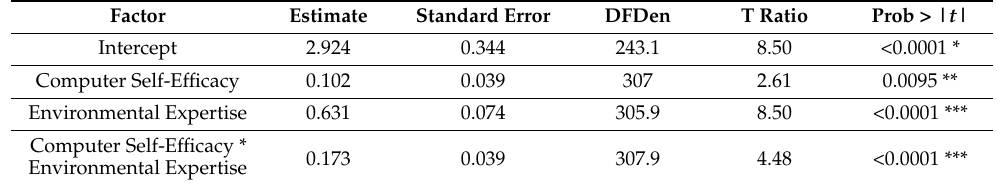
Table 3. Results of linear mixed models for computer self-efficacy and environmental expertise.